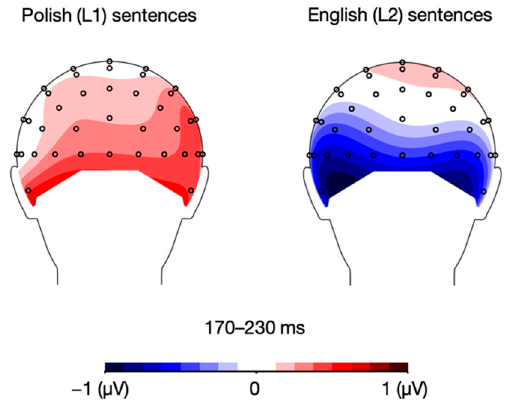
Figure 4. Topographic distribution of the difference between ERP amplitudes in the positive and negative mood conditions for Polish (L1) and English (L2) sentences in the 170–230 ms time window.